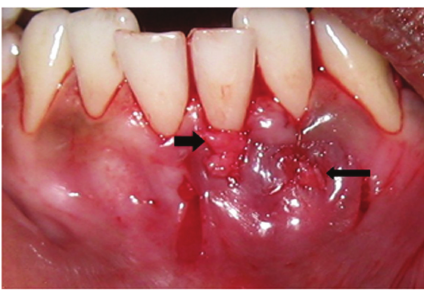
Figure 5: Extending the graft coronally into the prepared pouch (short and thick arrow-shows the graft placed in the prepared pouch); note coverage of the fenestration defect (long arrow) also.